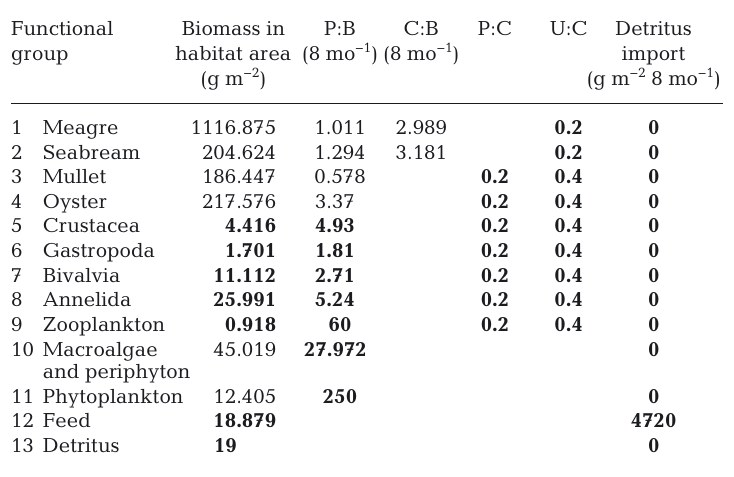
Table 2. Input data for the fish, oysters and macroalgae (FOM) model. P: pro- duction; B: biomass; C: consumption; U: unassimilated; Bold : values that were kept equal in all